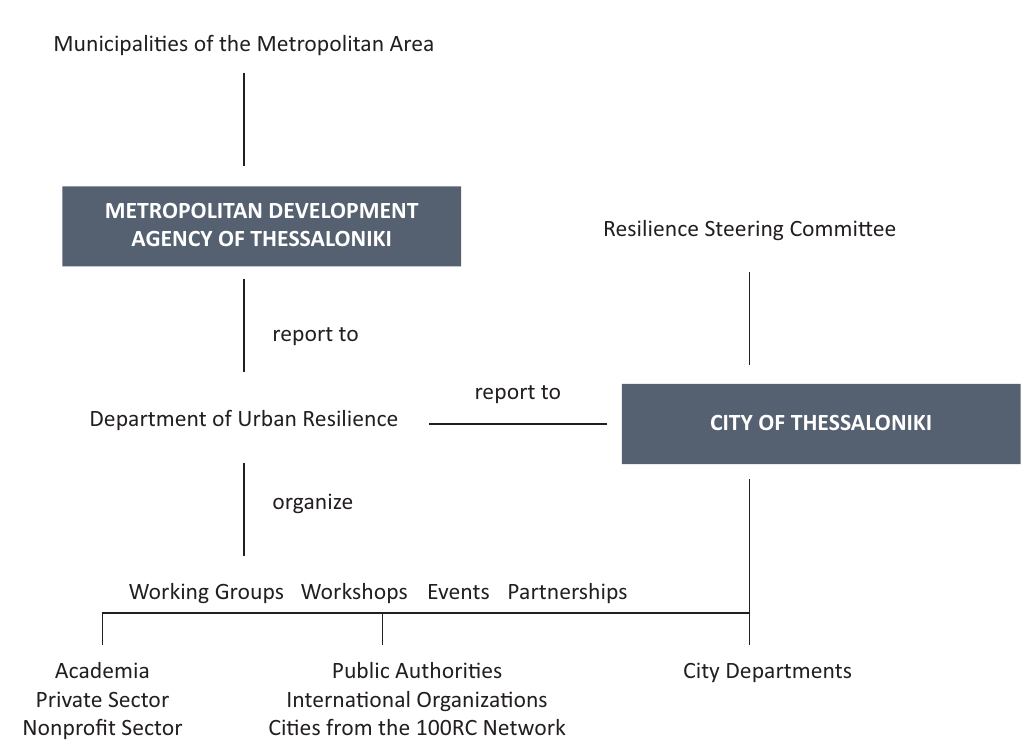
Figure 3. The organisational structure of Resilient Thessaloniki. Source: MoTh and Resilient Thessaloniki (2017, p. 24).